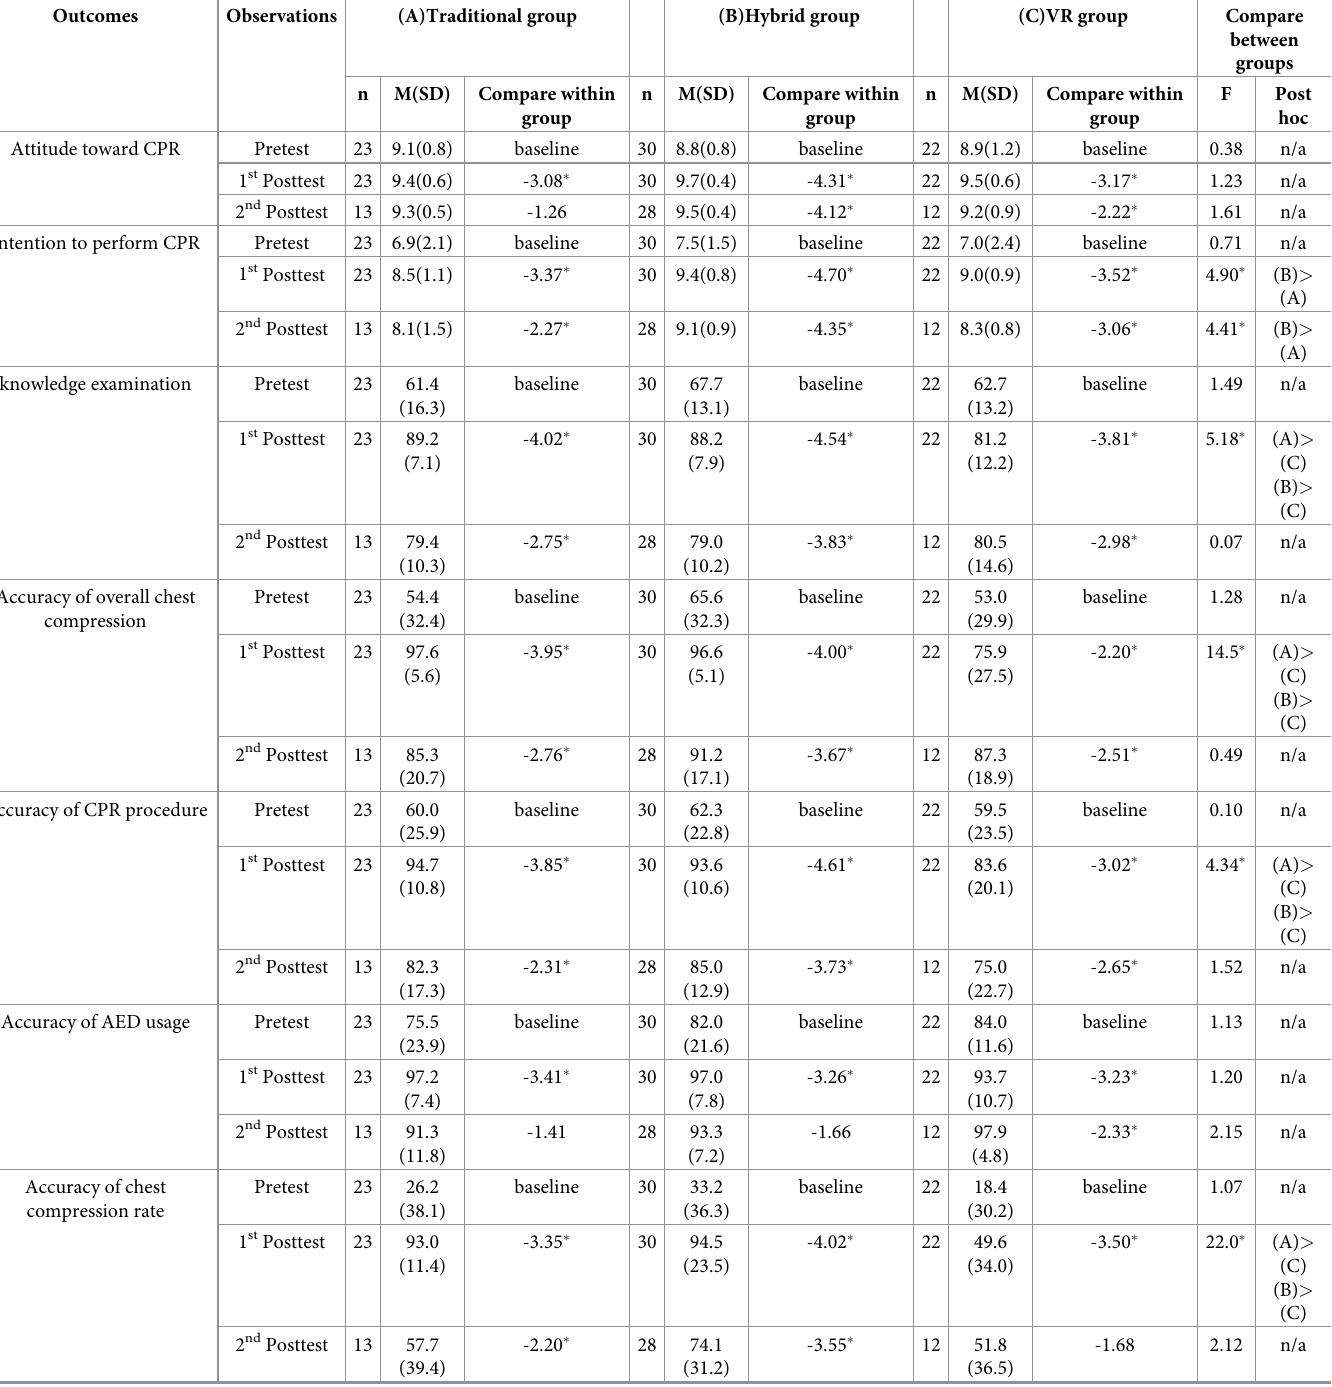
Table 2. Comparison of attitude, intention, knowledge, and performance (between and within groups).